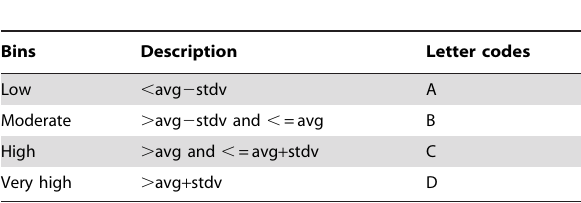
Table 3. Descriptions of the bins used to discretize the attributes of the F and C